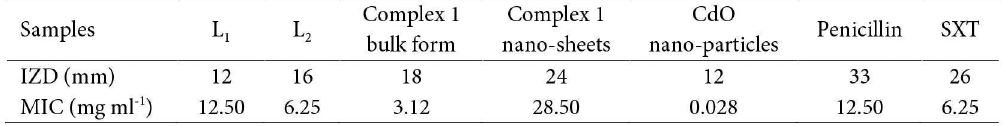
227 Nanochem Res 1(2): 222-228, Summer and Autumn